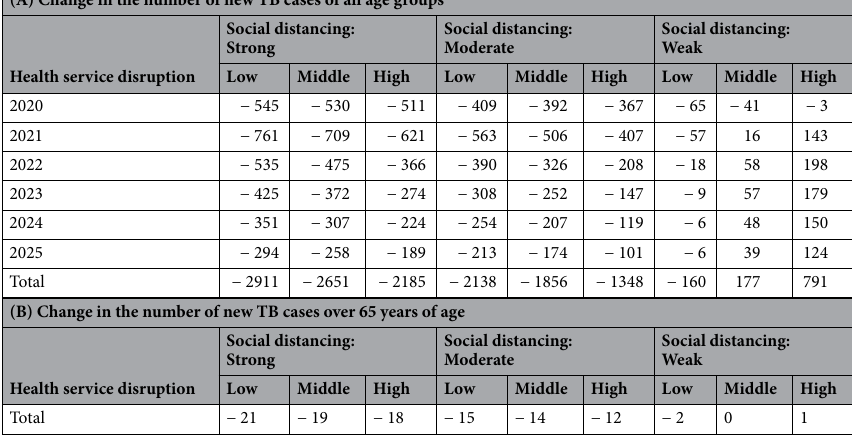
Table 3. Change in the number of new TB cases under each scenario of social distancing and health service disruptions compared to baseline.